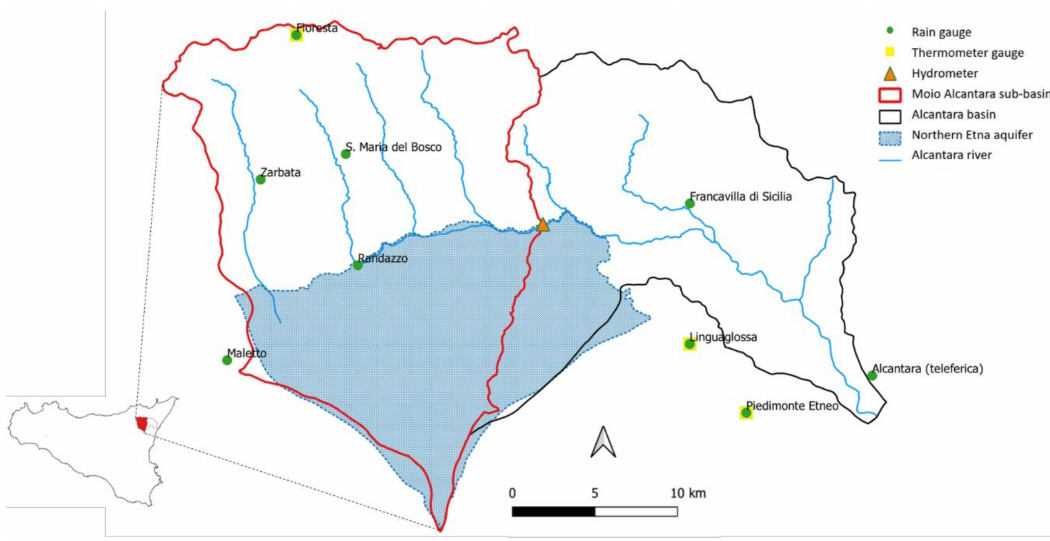
Figure 1. Northern Etna groundwater aquifer (in light blue), Alcantara sub-basin at Moio cross-section (in red), and pluviometric and thermometric